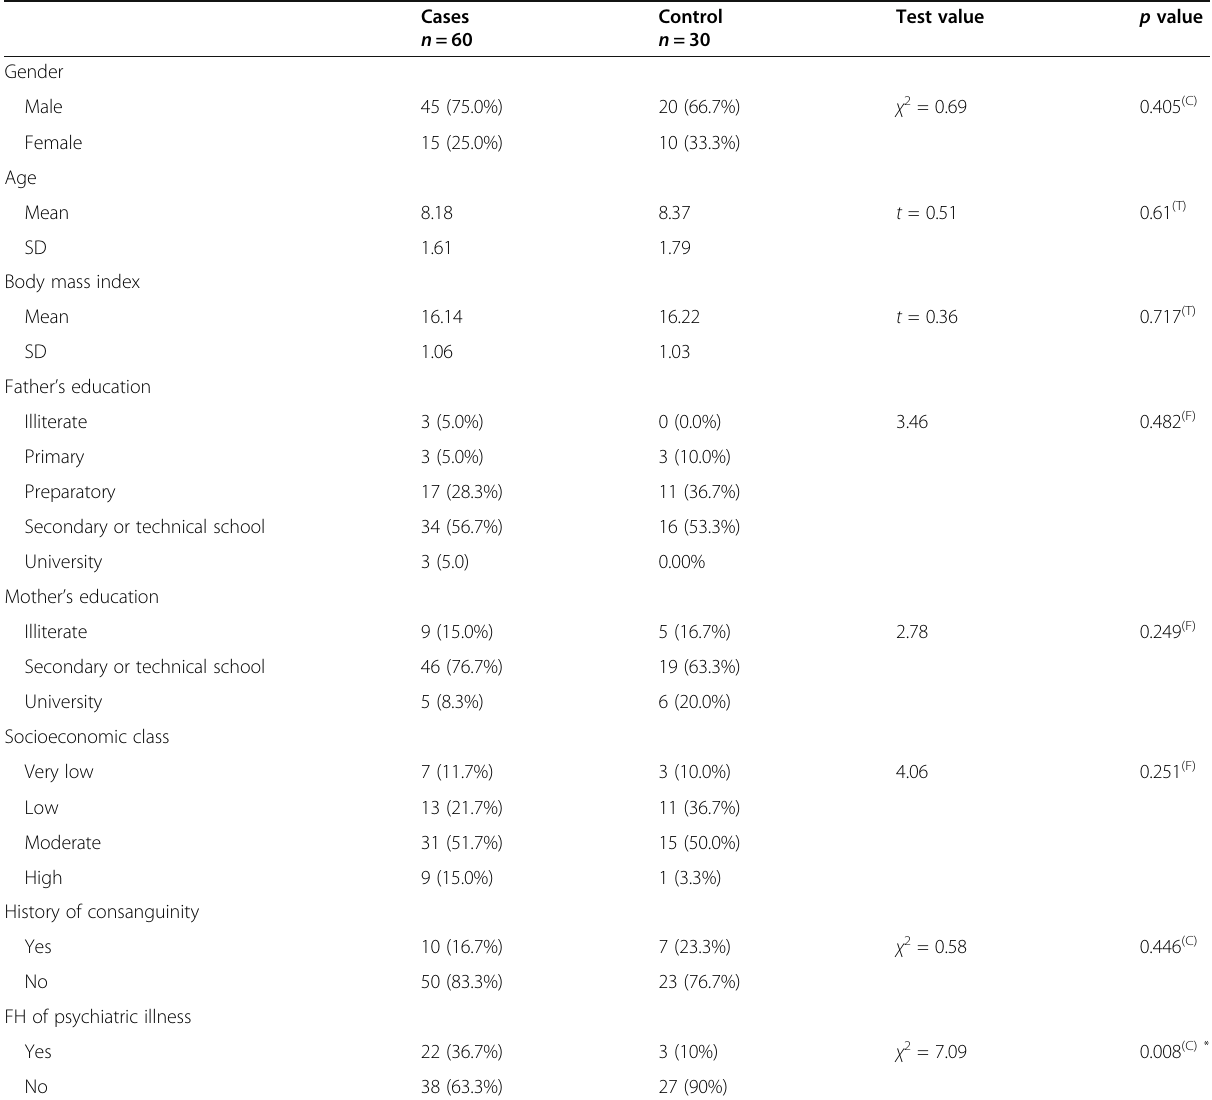
Table 1 Sociodemographic characteristics